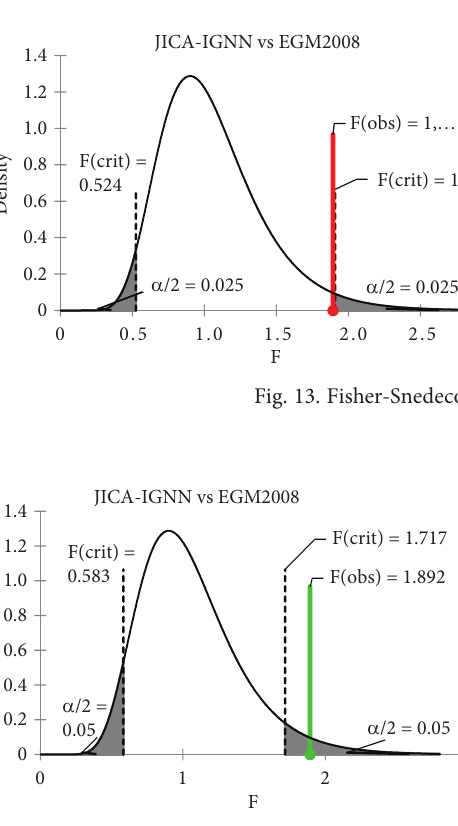
Fig. 14. Fisher-Snedecor Distributions, significance level 10%